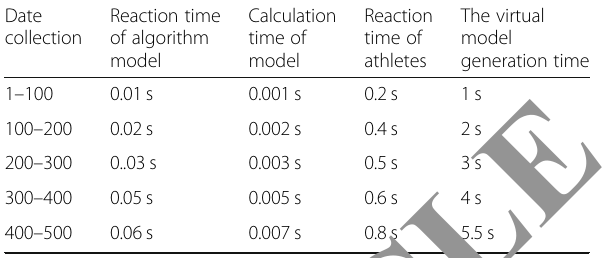
Table 1 Measures to improve the judicial execution plan in the administrative law system based on the annealing